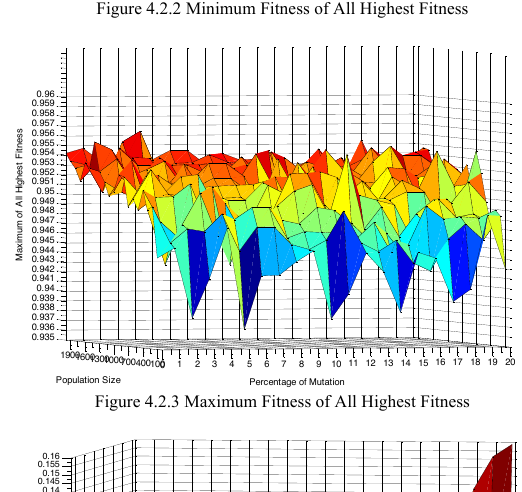
Figure 4.3.2 Minimum Fitness of All Highest Fitness